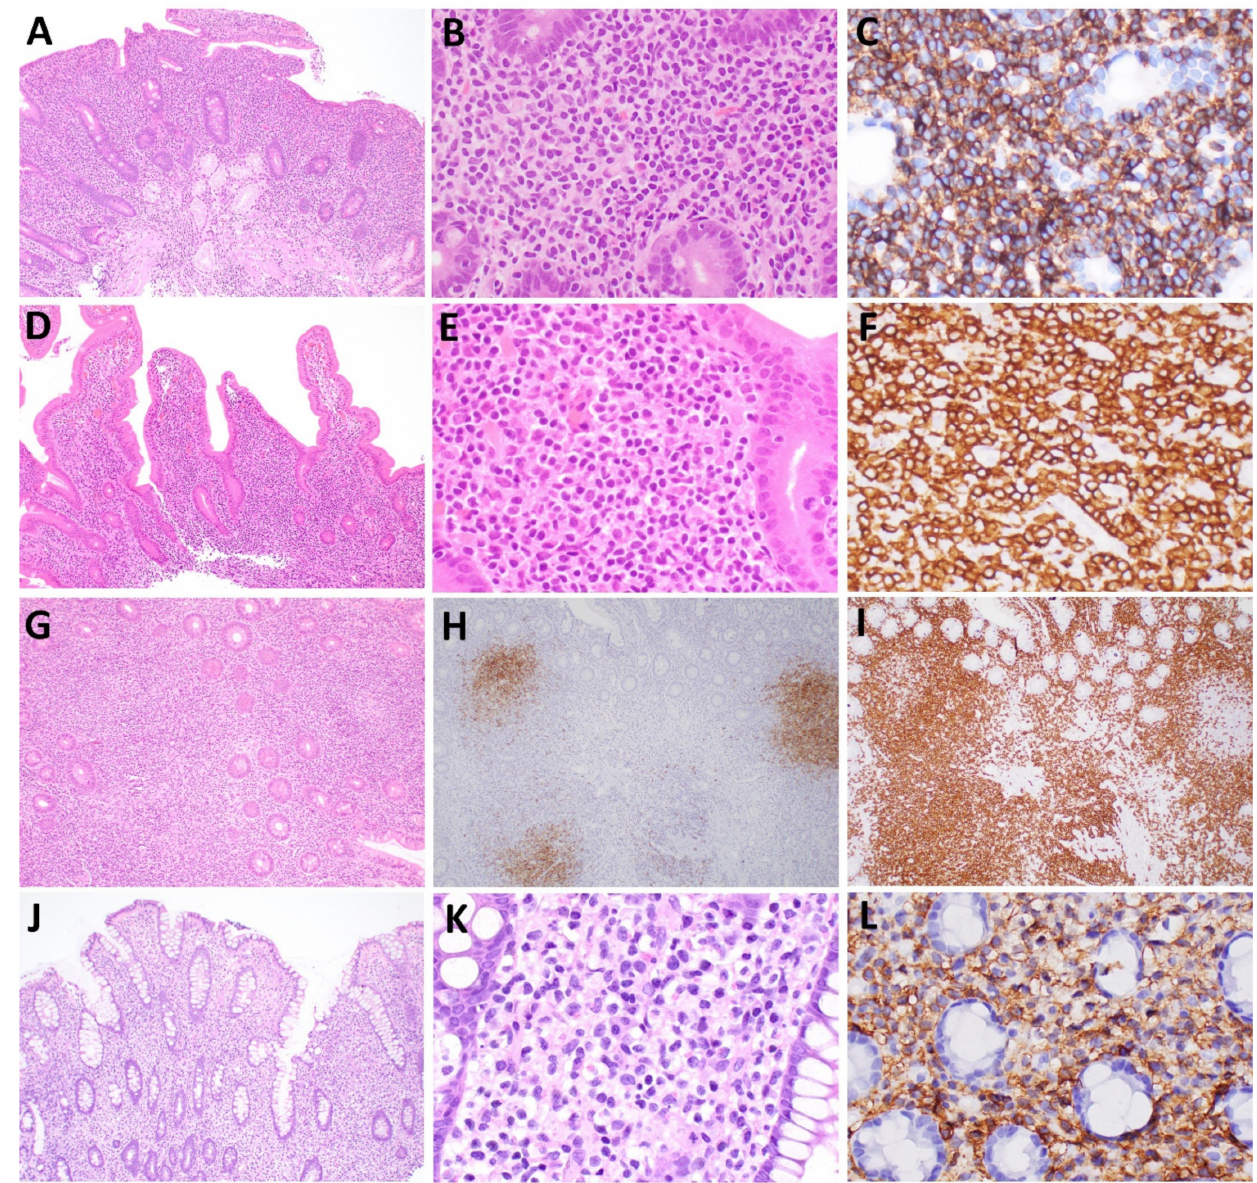
Figure 1. Histopathologic and immunophenotypic features of ITLPD-GI and NKCE. ( A – C ) CD4 + ITLPD-GI: ( A ) A duodenal biopsy shows expansion of the lamina propria by a dense lymphocytic infiltrate that extends into the submucosa, accompanied by villous atrophy and crypt hyperplasia. ( B ) The lymphocytes are small and have round or mildly irregular nuclei, condensed chromatin, incon- spicuous nucleoli, and scant cytoplasm. ( C ) The vast majority of lymphocytes express CD4. ( D – F ) CD8 + ITLPD-GI: ( D ) The lymphocytic infiltrate within the lamina propria mildly distends the lower portions of the villi; no villous atrophy or crypt hyperplasia is evident. ( E ) The lymphocytes are small and mature appearing and do not show significant atypia. ( F ) In this case, the lymphocytes are CD8-positive. ( G – I ) Reactive B-cell follicles: ( G ) Scattered, small lymphoid follicles can be seen in some cases, which are comprised of ( H ) B-cells (CD20 + ) and surrounded by neoplastic ( I ) T-cells (CD3 + ). ( J – L ) NKCE: ( J ) A colonic biopsy shows an infiltrate of lymphoid cells within the lamina propria that displaces the crypts. ( K ) The lymphoid cells are medium- to large-sized and have ovoid or irregular nuclei, fine chromatin, indistinct or small nucleoli, and moderate or abundant cytoplasm. ( L ) The cells express